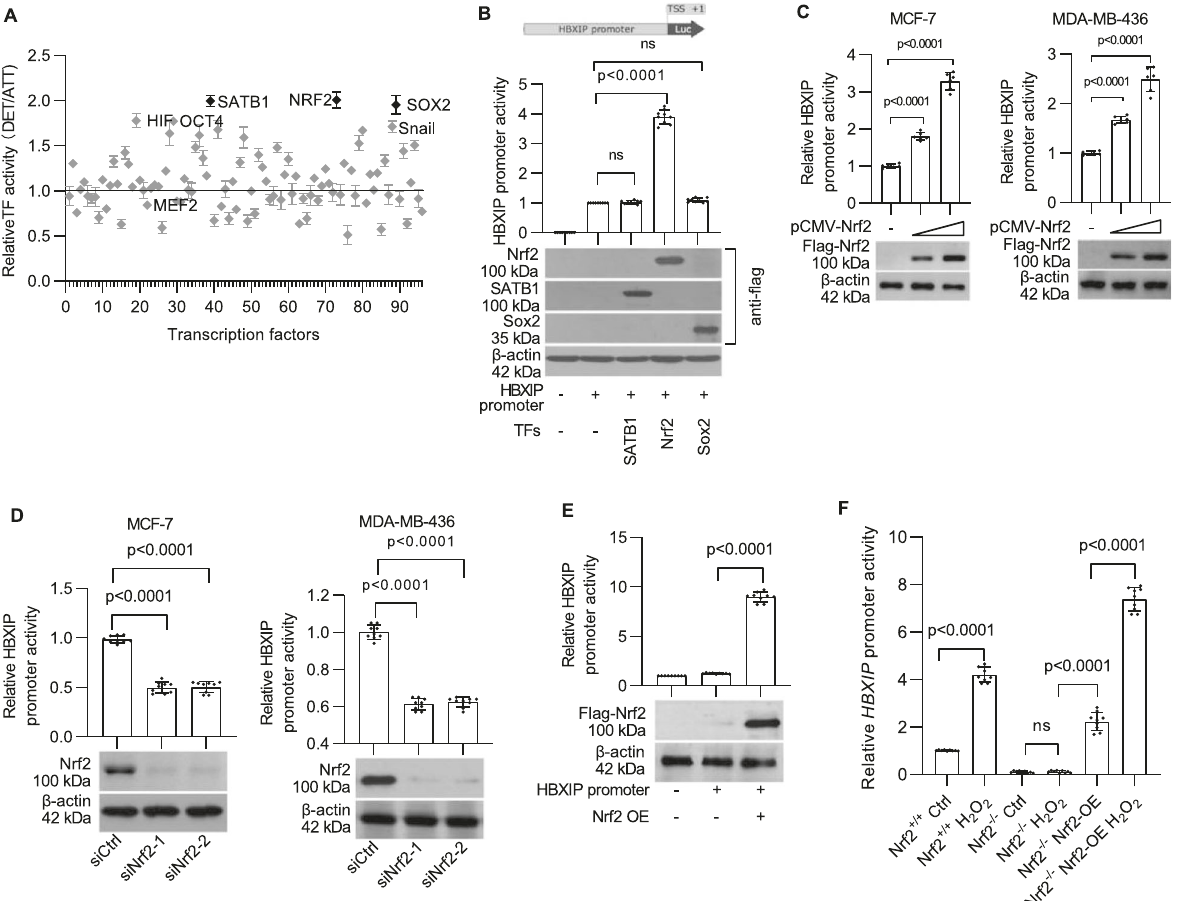
Fig. 2 Identi fi cation of Nrf2 as a positive regulator of the HBXIP gene. A The transcription factor pro fi ling assay identi fi ed TFs whose activity was altered in MCF-7 cells in response to detachment. B HBXIP promoter activity was investigated in TF-overexpressing MCF-7 cells. pGL- HBXIP FL promoter (from nt -2156 to + 357, + 1 from the TSS) reporter constructs were separately co-transfected with SATB1, Nrf2 and Sox2 expression vectors. The western blot shows SATB1, Nrf2, and Sox2 expression in transfected MCF-7 cells. C HBXIP promoter activity was activity in MCF-7 and MDA-MB-436 cells with Nrf2 knockdown. Nrf2 knockdown by two siRNAs was con fi rmed by western blotting. E HBXIP promoter activity was compared between Nrf2-overexpressing HEK293 cells and control cells. Nrf2 expression was con fi rmed by